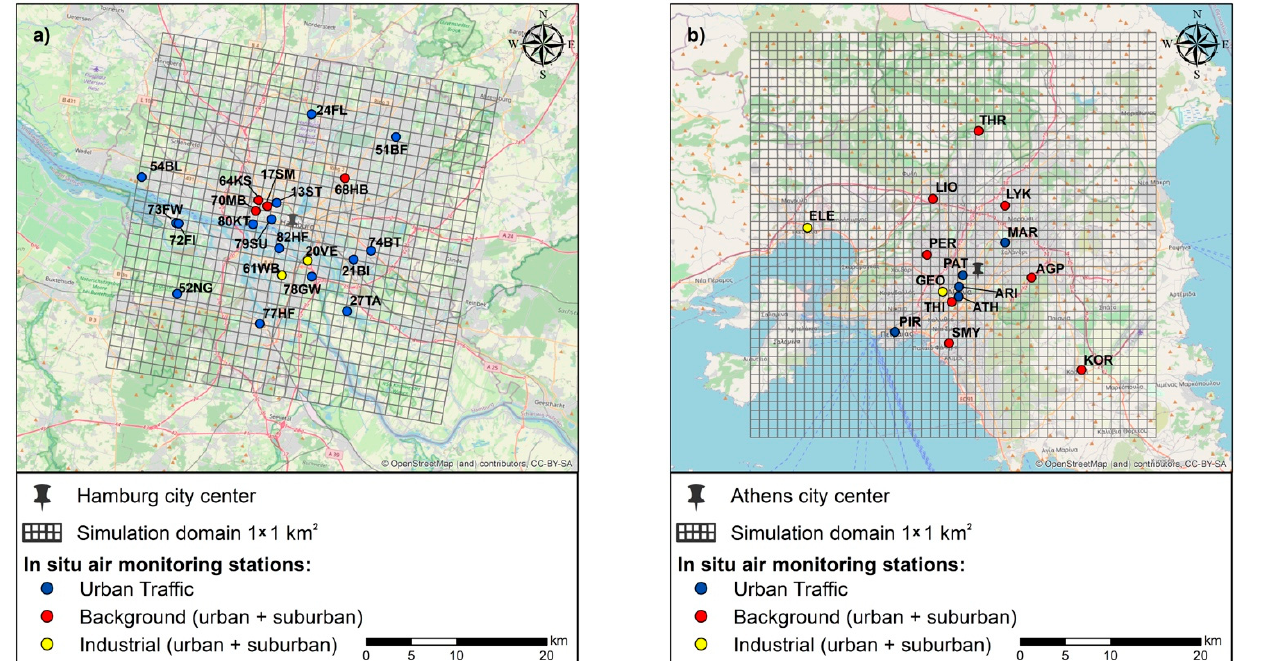
Figure 5. The cities of ( a ) Hamburg in Germany and ( b ) Athens in Greece. The gridded rectangles correspond to the air quality simulation domains. Sites correspond to the air quality measurement stations during the simulation periods, which are categorized by type.